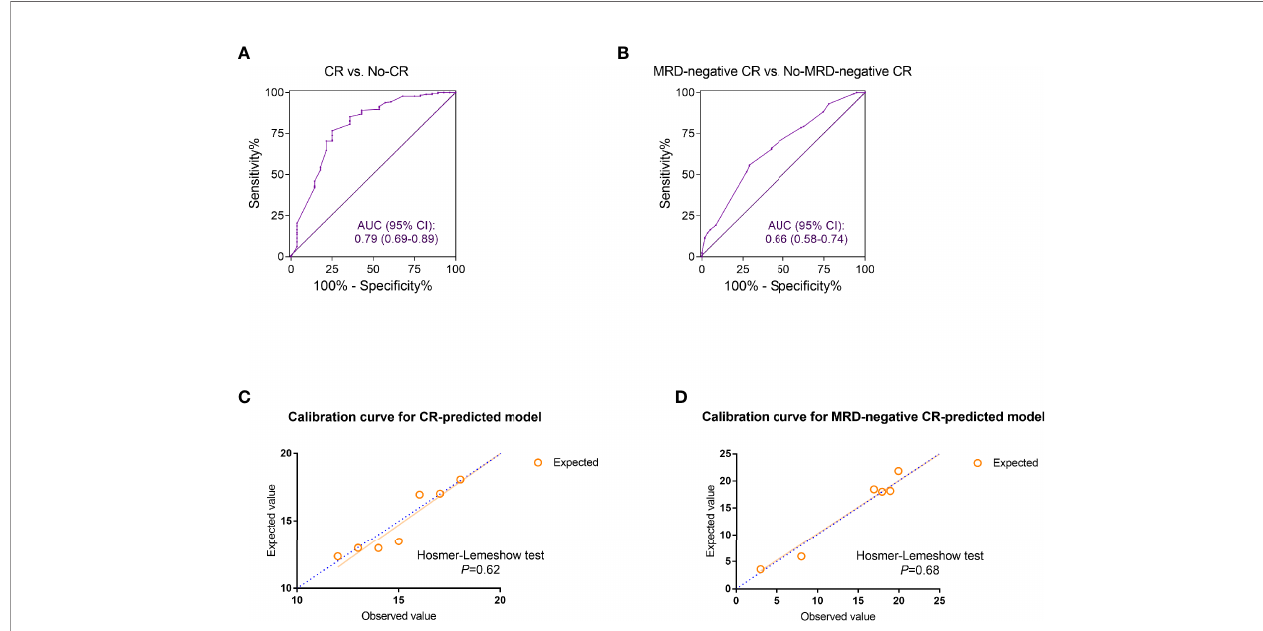
FIGURE 2 | The discrimination and calibration evaluation of the complete remission (CR) and minimal residual disease (MRD)-negative CR predicted models. (A, B) The receiver operating characteristic (ROC) curves discriminating the refractory or relapsed (r/r) B-cell acute lymphoblastic leukemia (ALL) patients who achieved CR (A) or MRD-negative CR (B) from those who did not. The area under the curve (AUC) of ROC was calculated for evaluation. (C, D) Calibration curves for the estimation of CR (C) and MRD-negative CR (D) . The observed and the model-expected numbers of events (CR and MRD-negative CR) were plotted on the x- and y-axes, respectively. p values generated from Hosmer – Lemeshow tests were also calculated for assessing the goodness of fi t of the constructed